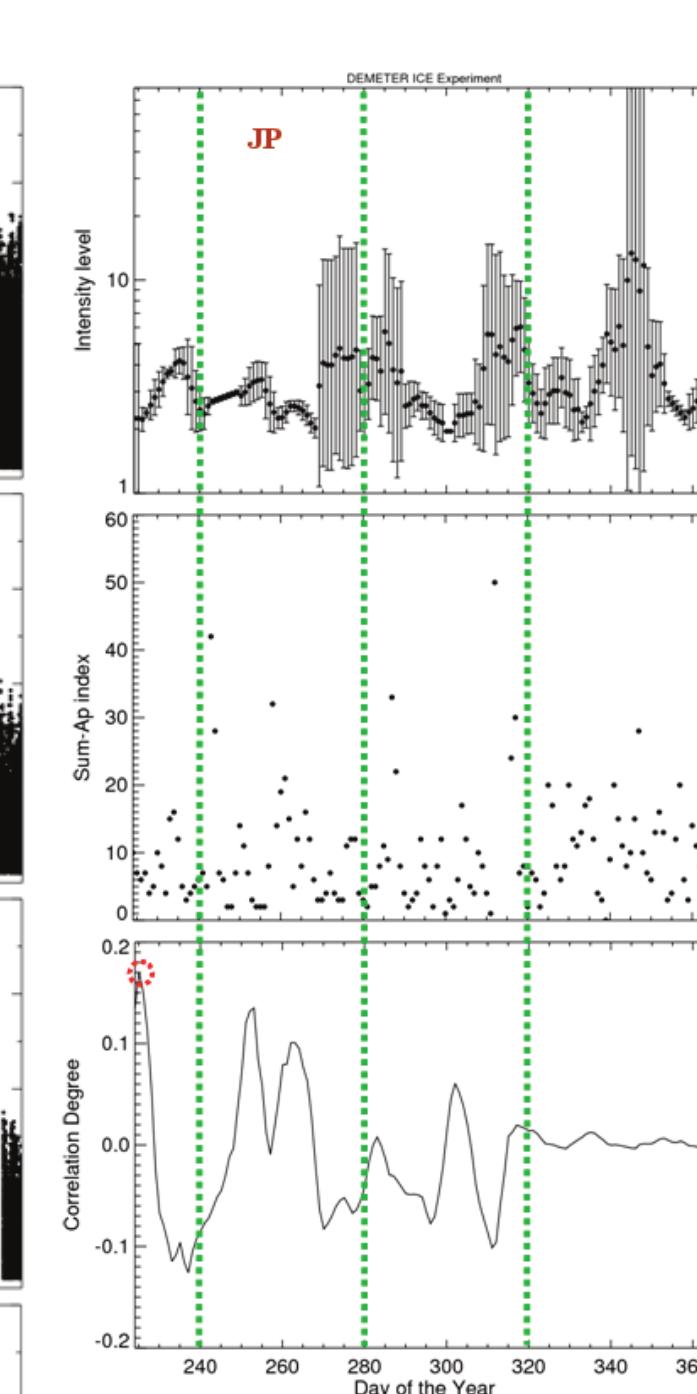
Figure 3. The VLF transmitter signals (top panel) and the daily Ap-index (second panel) and their estimated degree of correlation (bottom panel). The degree of correlation is about 15%, with a lag of <1